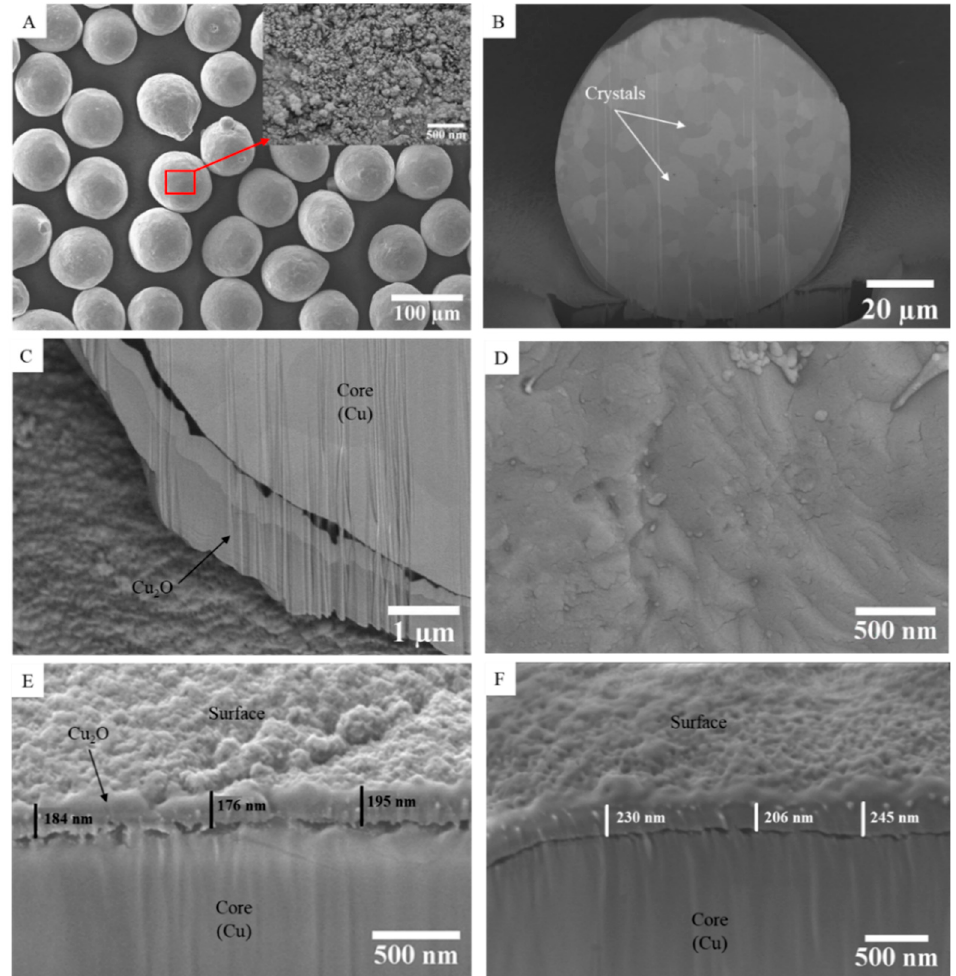
Figure 2. SEM observations of the Cu powders: ( A ) raw powder at low magnification; ( B ) cross- Figure section of one particle of the raw powder prepared by FIB; ( C ) cross-section of one particle of raw powder; ( D ) surface morphology of the reduced powder; ( E , F ) cross-sections of one particle of pow- der oxidized at 250 °C and 280 °C, respectively. Table 1. Thickness of the oxide layer for each powder batch.